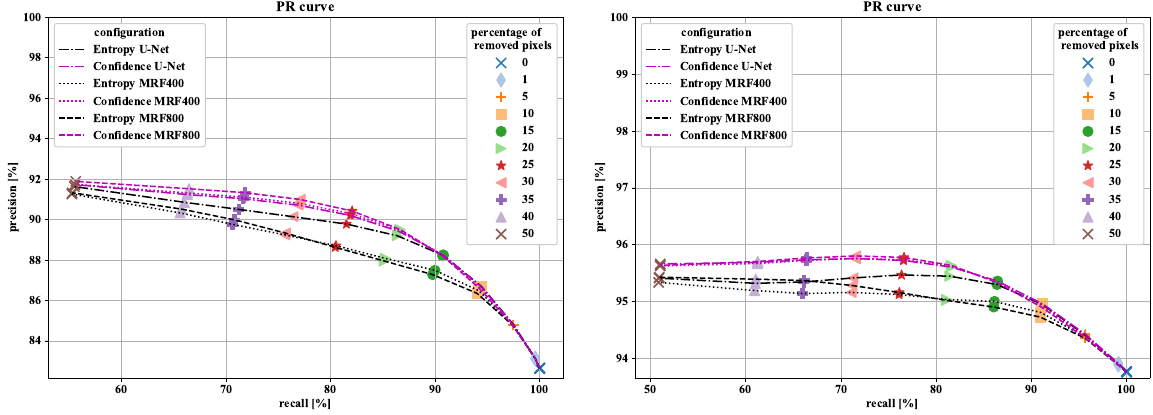
Figure 4. Precision-recall curve for each of the configurations with different percentage of removed pixels [%]. Here, a percentage of zero means that no pixels were removed due to uncertainty. Left: all classes are considered, right: only the binary classification building - no building is